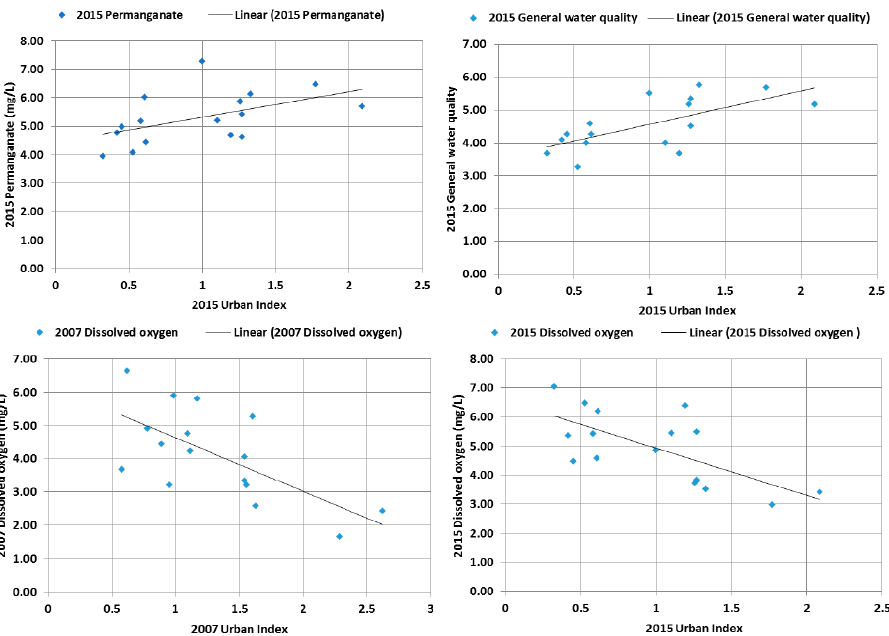
Figure 4. Relationships between water quality indicators and I URB .